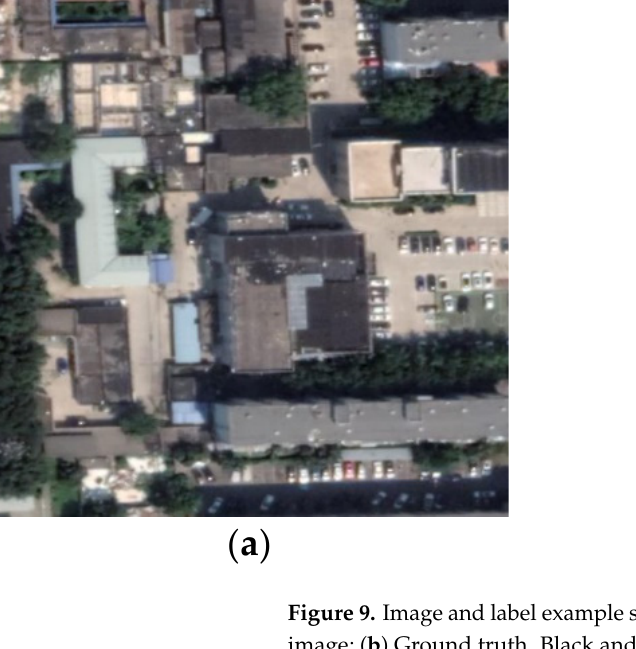
Figure 8. Image and label example selected from the WHU dataset: ( a ) Original image; ( b ) Ground truth. Black and white pixels mark non-building and building, respectively.